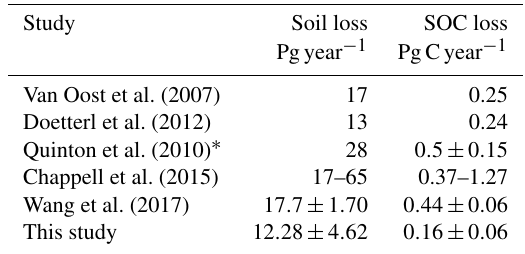
Table 6. Comparison of our model estimates of agricultural soil and SOC loss fluxes for the year 2005 with high-resolution model/observation